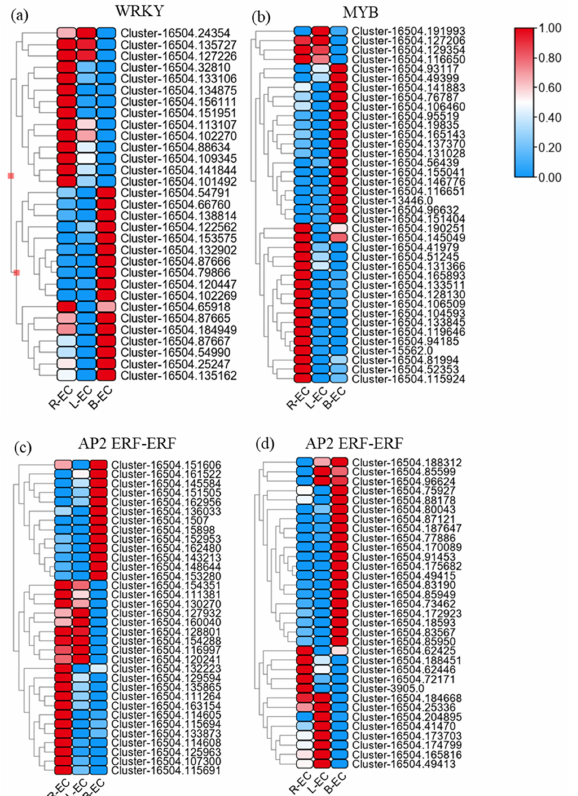
Figure 5. Differences in the expression levels of the WRKY, MYB, and AP2-ERF-ERF families of genes between different Korean pine cell lines. Heatmap indicate the gene expression level by Log2 [FPKM] with a rainbow color scale .